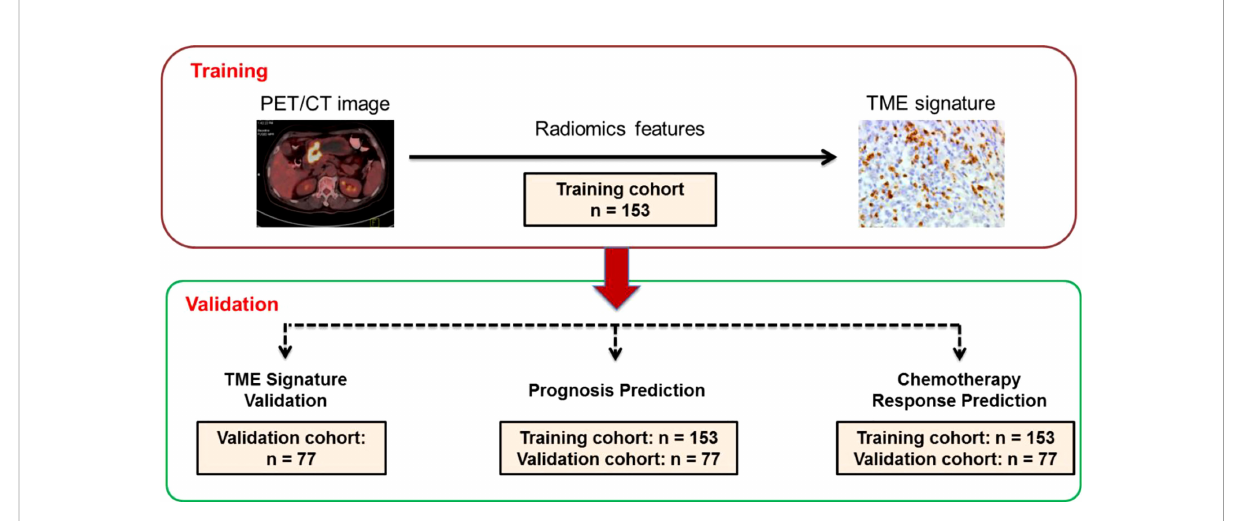
FIGURE 1 Study design for the discovery and validation of a PET/CT radiomic signature for the tumor immune microenvironment signature in gastric cancer. PET/CT image: positron emission tomography/computer tomography image. IH,: immunohistochemistry. Training cohort (n=153); Validation cohort